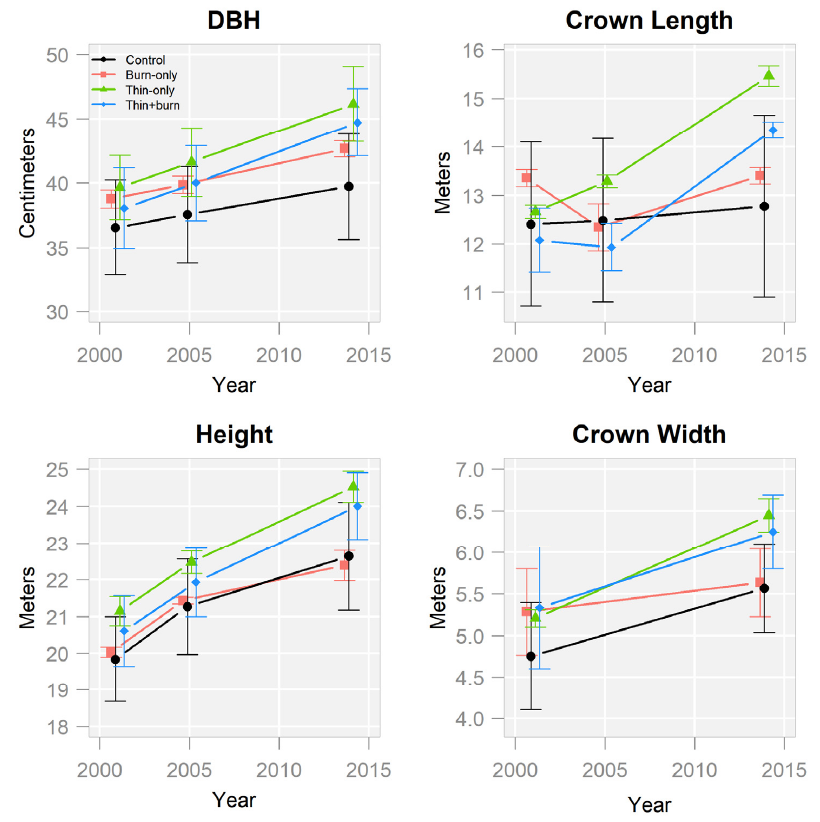
Figure 2. Stem and crown dimensions by treatment and year for ponderosa pine greater than 25 cm dbh.